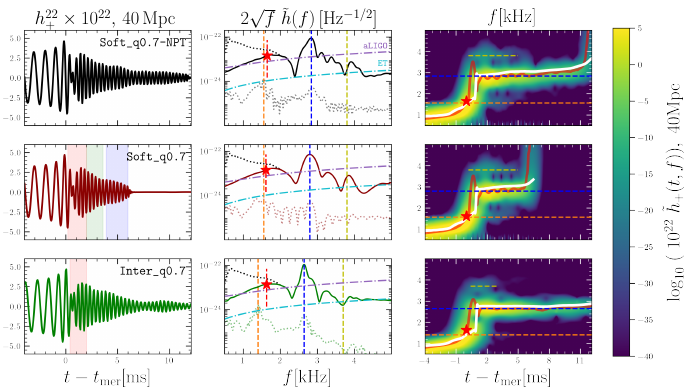
Figure 3. Shown above is the h 22 + of the strain (left), the power-spectral density of the e ff ective strain (middle), and the spectrogram (right) of the h 22 + of the soft model with (top) and without quark matter (center) as well as the intermediate model (bottom) for q = 0 . 7 and M chirp = 1 . 188. See [26] for